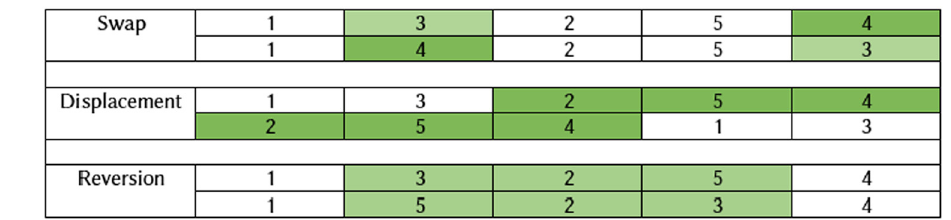
Figure 10: Illustration of mutation